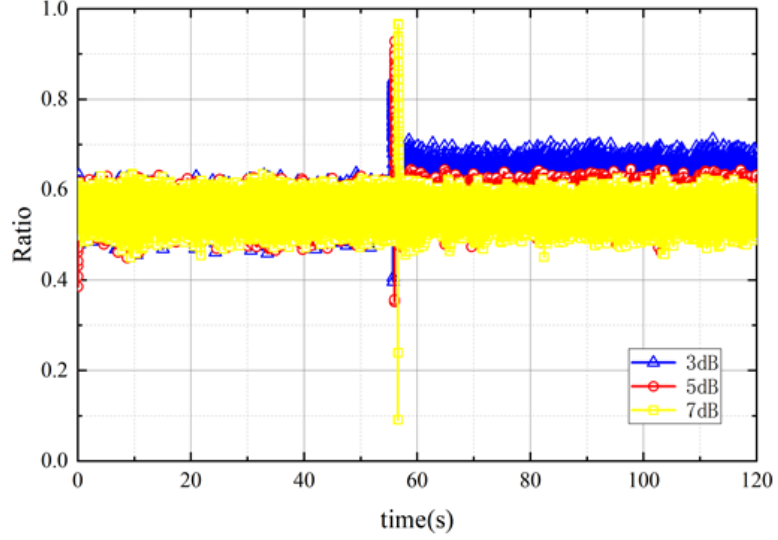
Figure 8. The Ratio with different spoofing power gain.